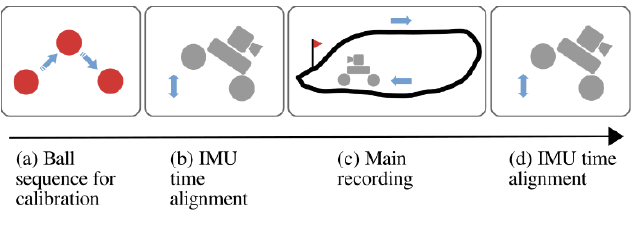
Fig. 5. Time dimension structure of each